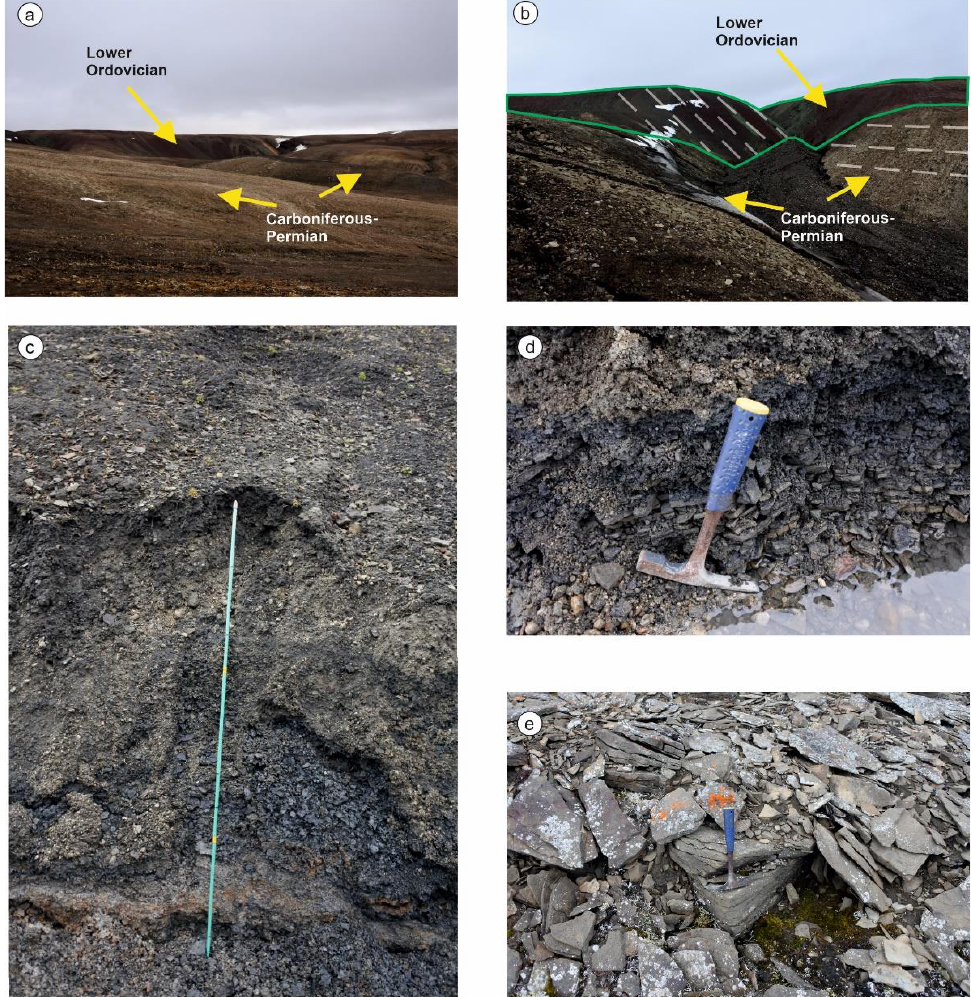
Figure 4. Field photographs of studied Carboniferous–Permian deposits: ( a )—General view of the study area, ( b )—close up view of the relationship between Lower Ordovician and Upper Paleozoic deposits, ( c )—general view of an outcrop of Carboniferous–Permian deposits, ( d )—intercalated sandstones and siltstones with layers of coal, ( e )—cross-bedded sandstones. Lower Ordovician deposits are overlain by Carboniferous–Permian terrigenous